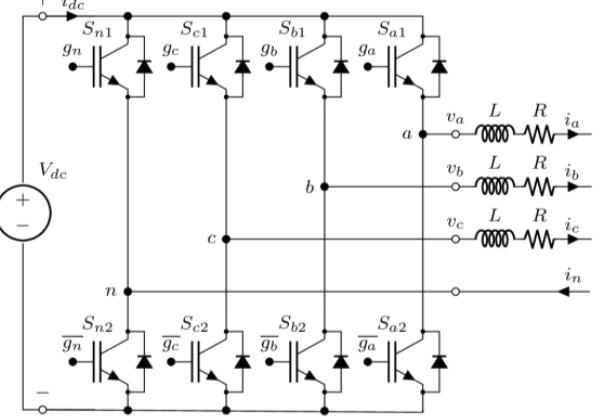
Figure 1. Circuit scheme of a three-phase four-leg inverter.